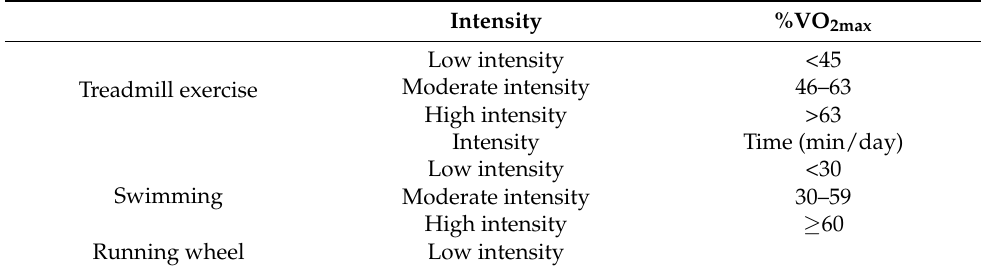
Table 2. Classification of mice exercises